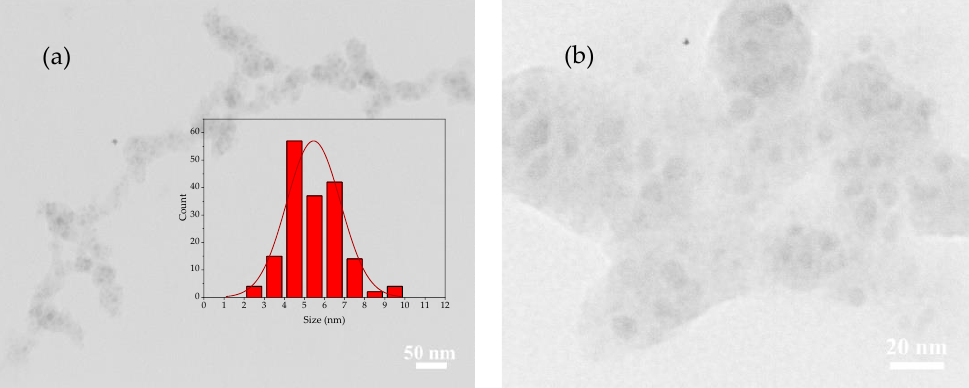
Figure 2. Typical TEM images of MoS 2 QDs ( a ) 50 nm scale and ( b ) 20 nm scale alongside size distribution, in inset ( a ), generated by pulsed laser at 1064 nm, 10 ns, 1.5 J/cm 2 , and 5 Hz during cryogenic PLA synthesis process.